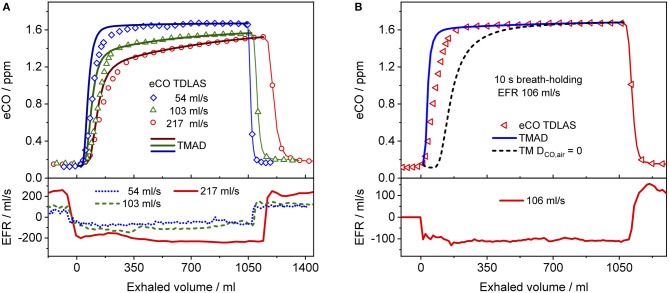
Comparison between measured (hollow markers) and model-predicted (solid lines) eCO profiles for different EFRs (A), and 10 s breath-holding (B) for subject 2. For clarity, only every 2nd, 4th, and 7th experimental data point is shown in phase III of the eCO profiles corresponding to EFRs of 217, 103, and 54 ml/s in (A), and every 4th data point is shown in phase III of the eCO profile in (B). A corresponding simulation without axial diffusion (short-dashed line) is shown in (B). Lower panels present corresponding real-time EFR data recorded by the breath sampler.